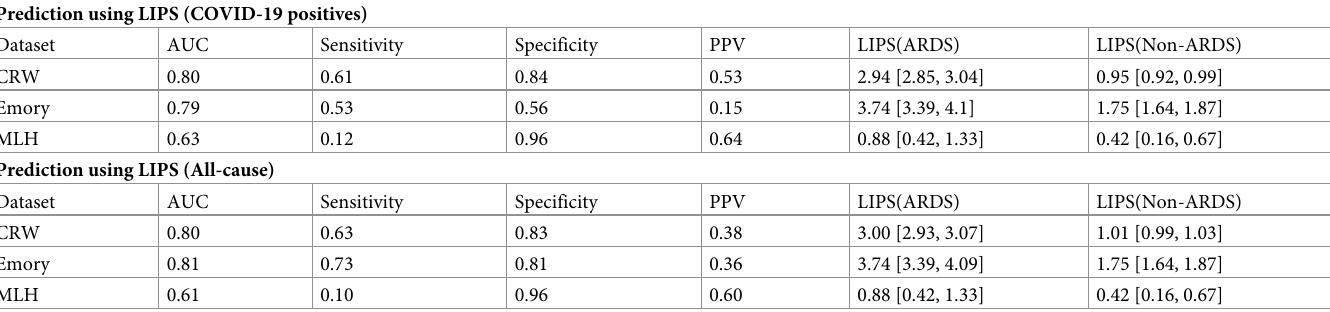
We compared the performance of the eARDS model to that of the Lung Injury Prediction Score (LIPS) for predicting ARDS (Table 5). The eARDS model performed better than Table 5. Analysis of the clinical LIPS benchmark across the three